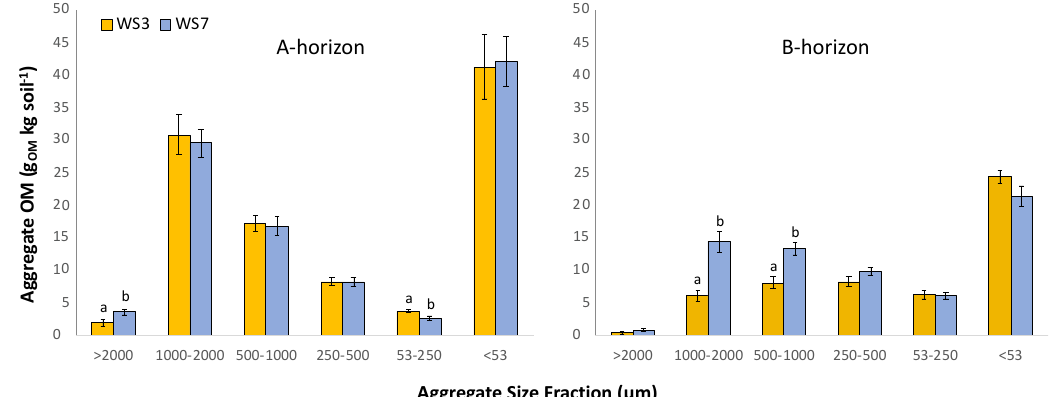
Figure 3. Organic matter within each aggregate size class by watershed (WS3-FERT and WS7-REF) in A-horizon and B-horizon: for each horizon, bars with different lowercase letters within each aggregate size fraction are significantly different according to Kruskal–Wallis means comparison ( p < 0.05).